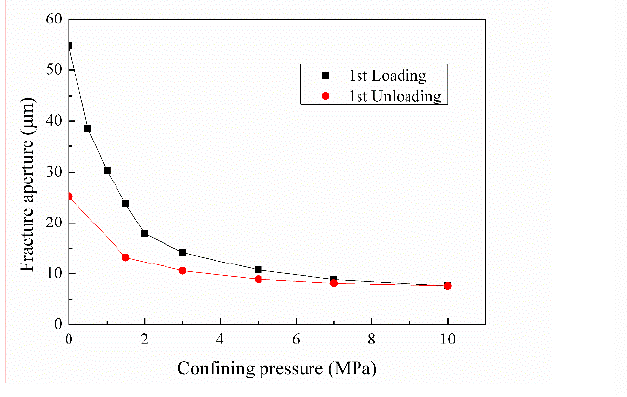
Figure 9. The measurement of fracture aperture at the first 0 MPa. Figure 10 is drawn according to the measurement results of fracture aperture at a fixed position under different confining pressures of two cycles.